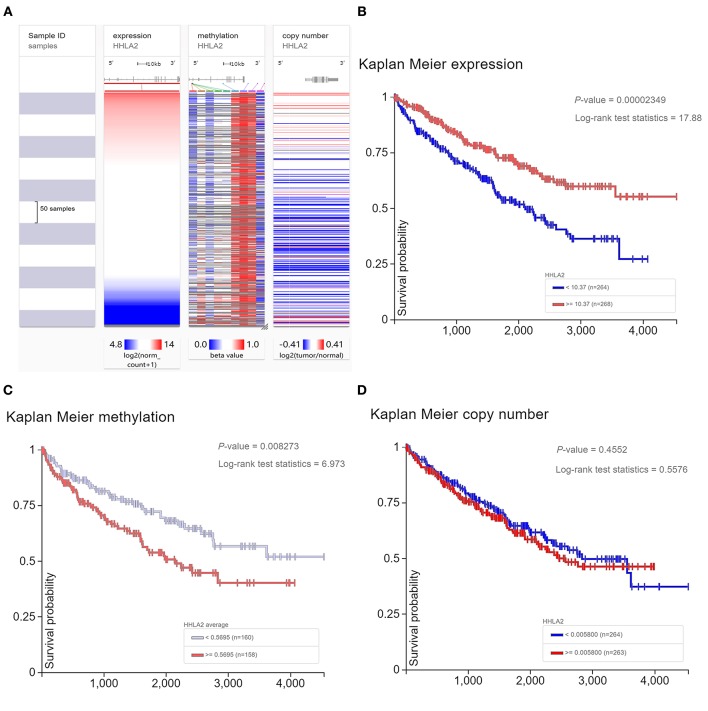
The Heatmap and Kaplan Meier curves of expression level, methylation status, copy number variant of HHLA2. (A) The heatmap shows the expression level, methylation status, copy number variant of HHLA2 in the TCGA database, determined by UCSC Xena. (B–D) Kaplan Meier plot shows the over-expression and hypomethylation of HHLA2 is favorable prognostic factor for KIRC patients.